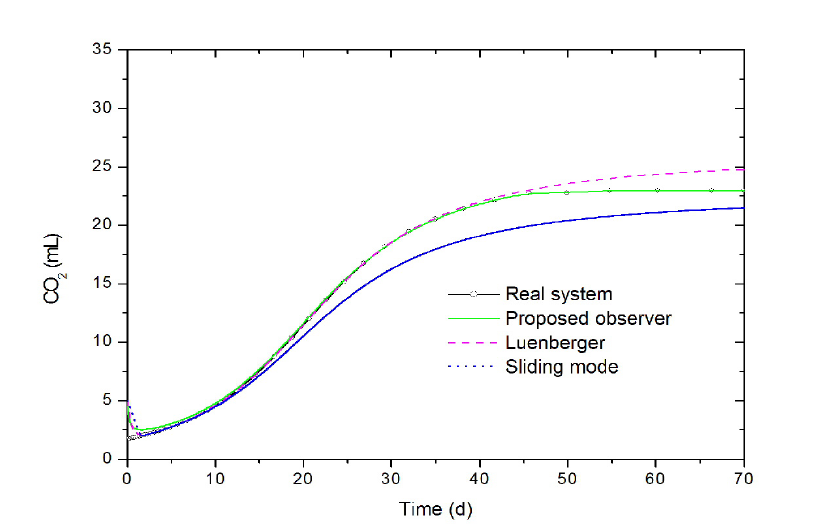
Figure 6. Simulation and comparison of the continuous-time observers, proposed observer vs. real system: Dynamics of the CO 2